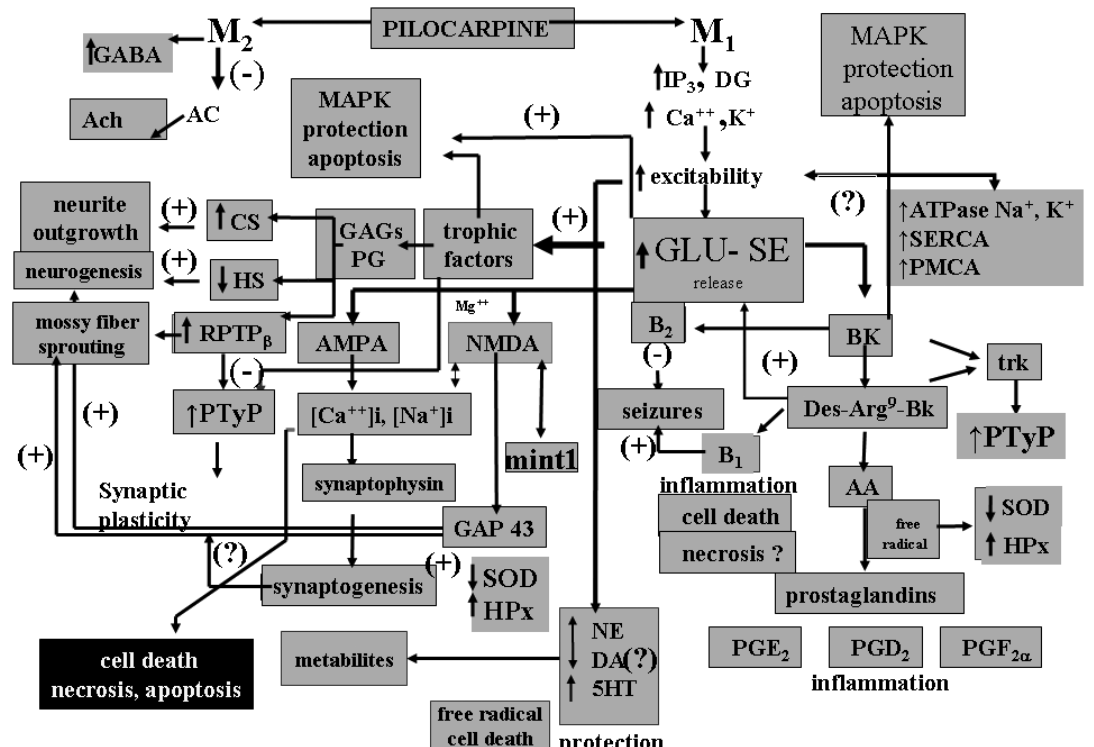
Fig. 1 – Main biochemical pathways and physiological consequences involved in the pilocarpine model. MAPK – mitogen activated protein kinase; Glu –glutamate; ATPase – ATPase sodium, potassium; SERCA – calcium ATPase from sarco-endoplasmatic reticulum; PMCA – calcium ATPase from plasma membrane; BK – bradykinin, Des-Arg9BK – des-Arg9 bradykinin; AA – arachidonic acid; PGE2 – prostaglandins E2, PGD2 – prostaglandin D2, PGF2 α – prostaglandin F2 α ; GAGs – Glycosaminoglycans; CS – chondroitin sulfate; HS – heparan sulfate; RPTP β – Receptors Protein Tyrosin Phosphatase β ; PG – Proteoglycans, PTyP – phosphotyrosin protein, SE – status epilepticus; GAP-43 – growth associated phosphoprotein-43, NMDA – N-methyl-D-aspartate; NE – neradrenaline; DA – dopamine, 5HT – serotonin; SOD –